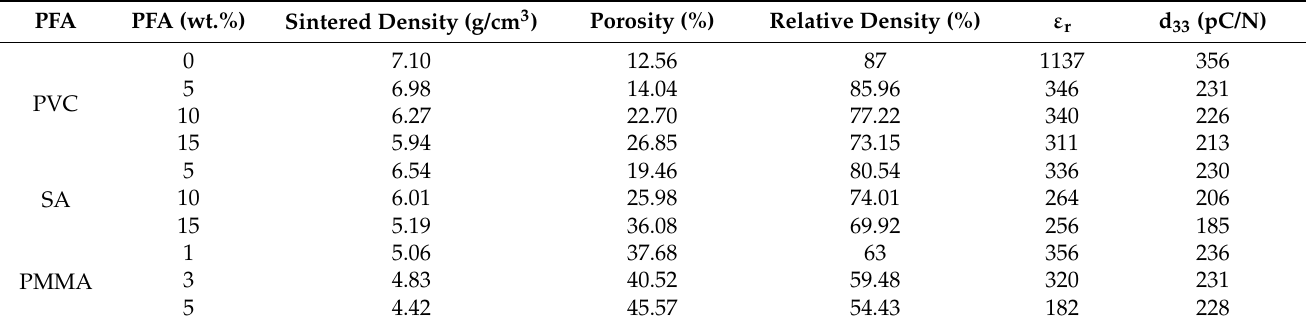
Table 6. The measured density, porosity, piezoelectric and dielectric properties of porous PZT-PCN ceramics (Reprinted from Ref. [92], copyright (2019), with the kind permission of Elsevier